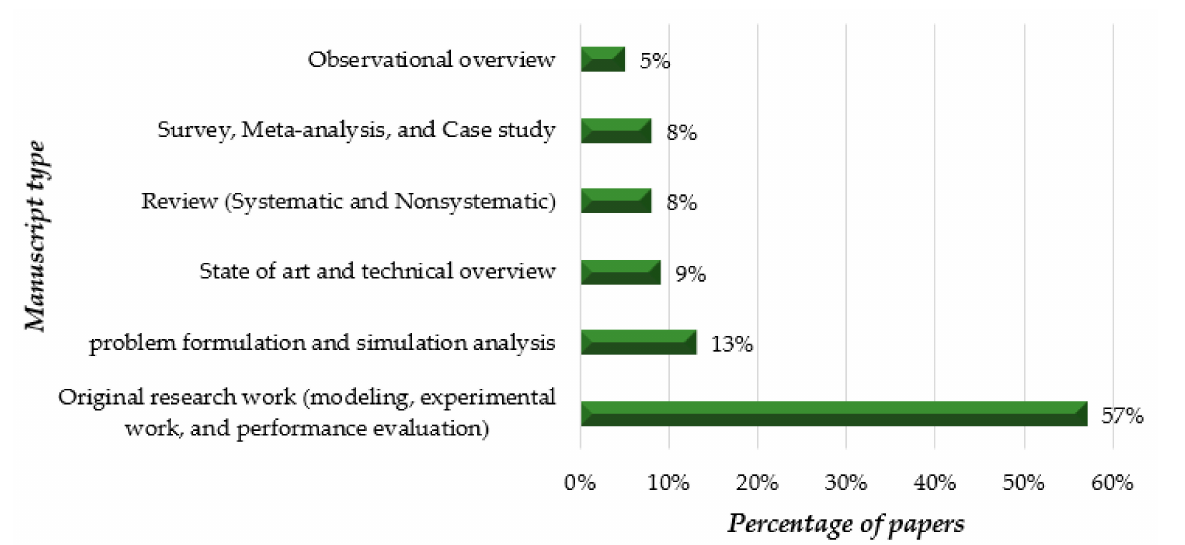
Figure 8. The percentage of manuscript types in the relevant top 100 cited